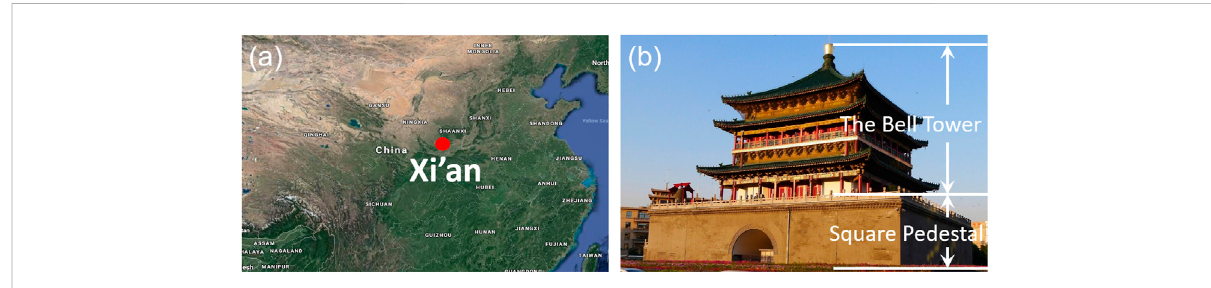
FIGURE 1 Location and the basic structure of the Xi ’ an Bell Tower.